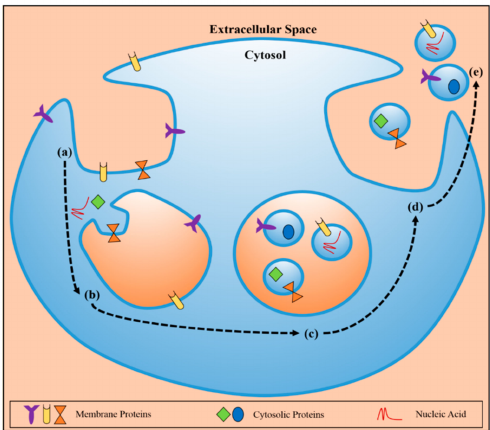
Figure 4. Schematic representation of the formation of exosomes and their respective release to the bloodstream by [78], licensed under CC BY